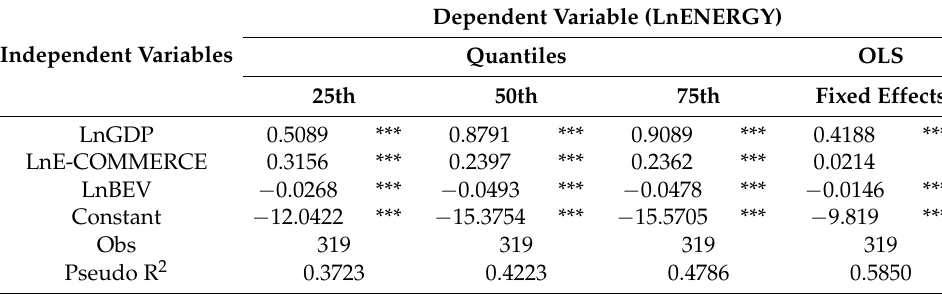
Table 10. Results from QRM and OLS with fixed